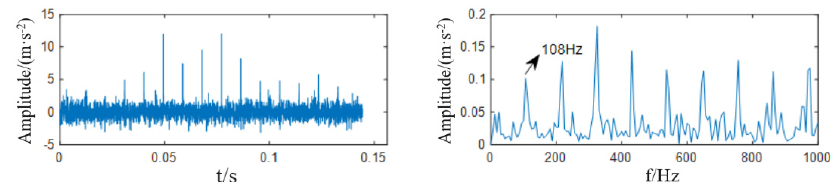
Figure 13. Time-domain diagram and envelope diagram of the experimental signal after outer ring fault enhancement.